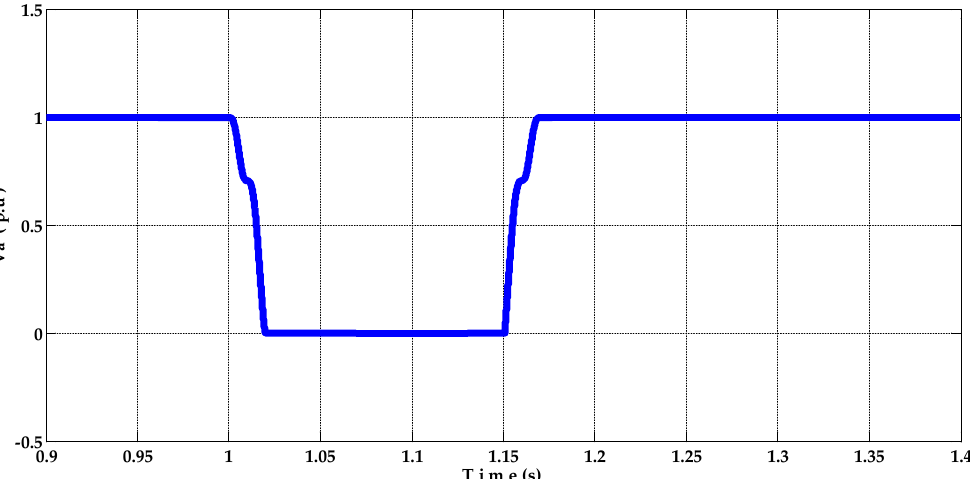
Figure 12. DC link voltage of BDFRG with and without the proposed crowbar under symmetrical fault occurrence.